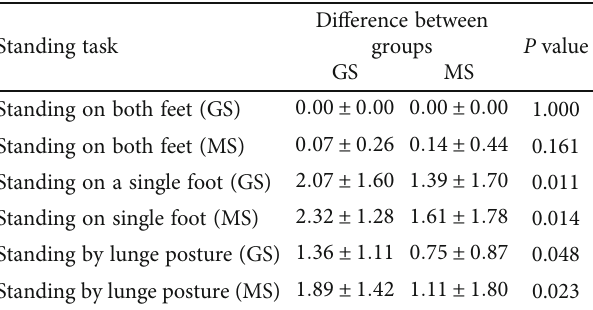
Table 3: Comparison of BESS score between